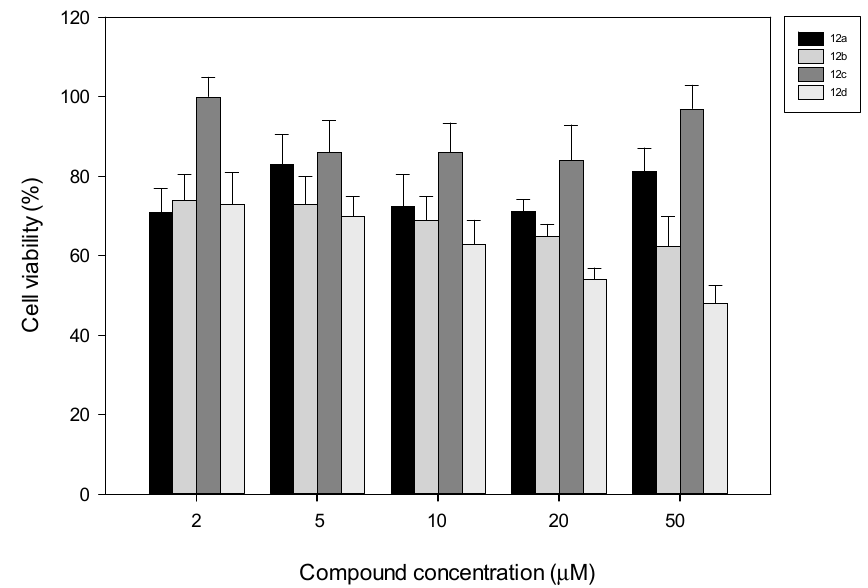
Figure 2. Effect of synthesized compounds on cell viability. NIH-3T3 cells were exposed 72 h at indicated concentration of 12a , b , c , d . Inhibition activity of compounds was expressed as percentages of control (0.5% DMSO). Each point represents the mean ± SD of the six experiments.